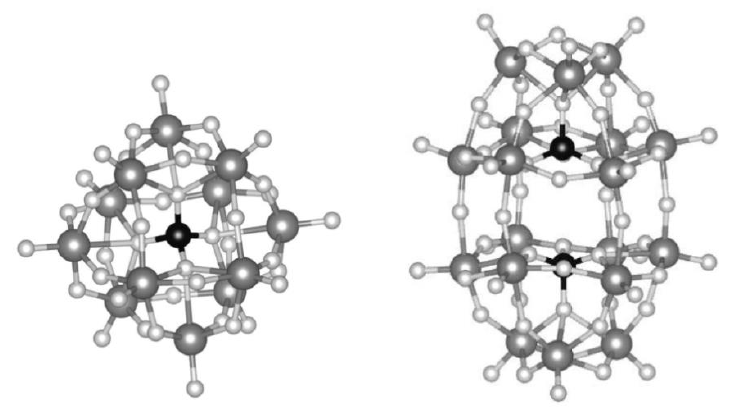
Figure 13. Ball and stick representations of two of the most common HPA variants. P (black), Mo (dark grey), O (light grey) [43]. Reprinted with permission from [43]. Copyright 2014, Elsevier.